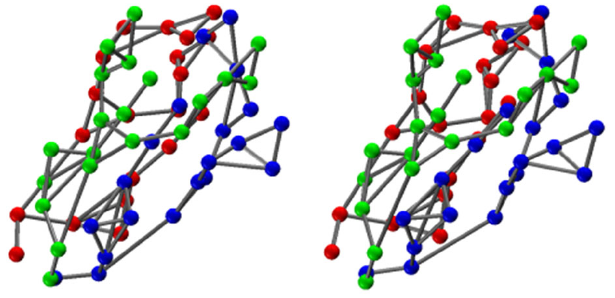
Figure 4. CG structure visualization: AAMD validation simulation final frame state ( left ). CGMD simulation final frame state ( right ).